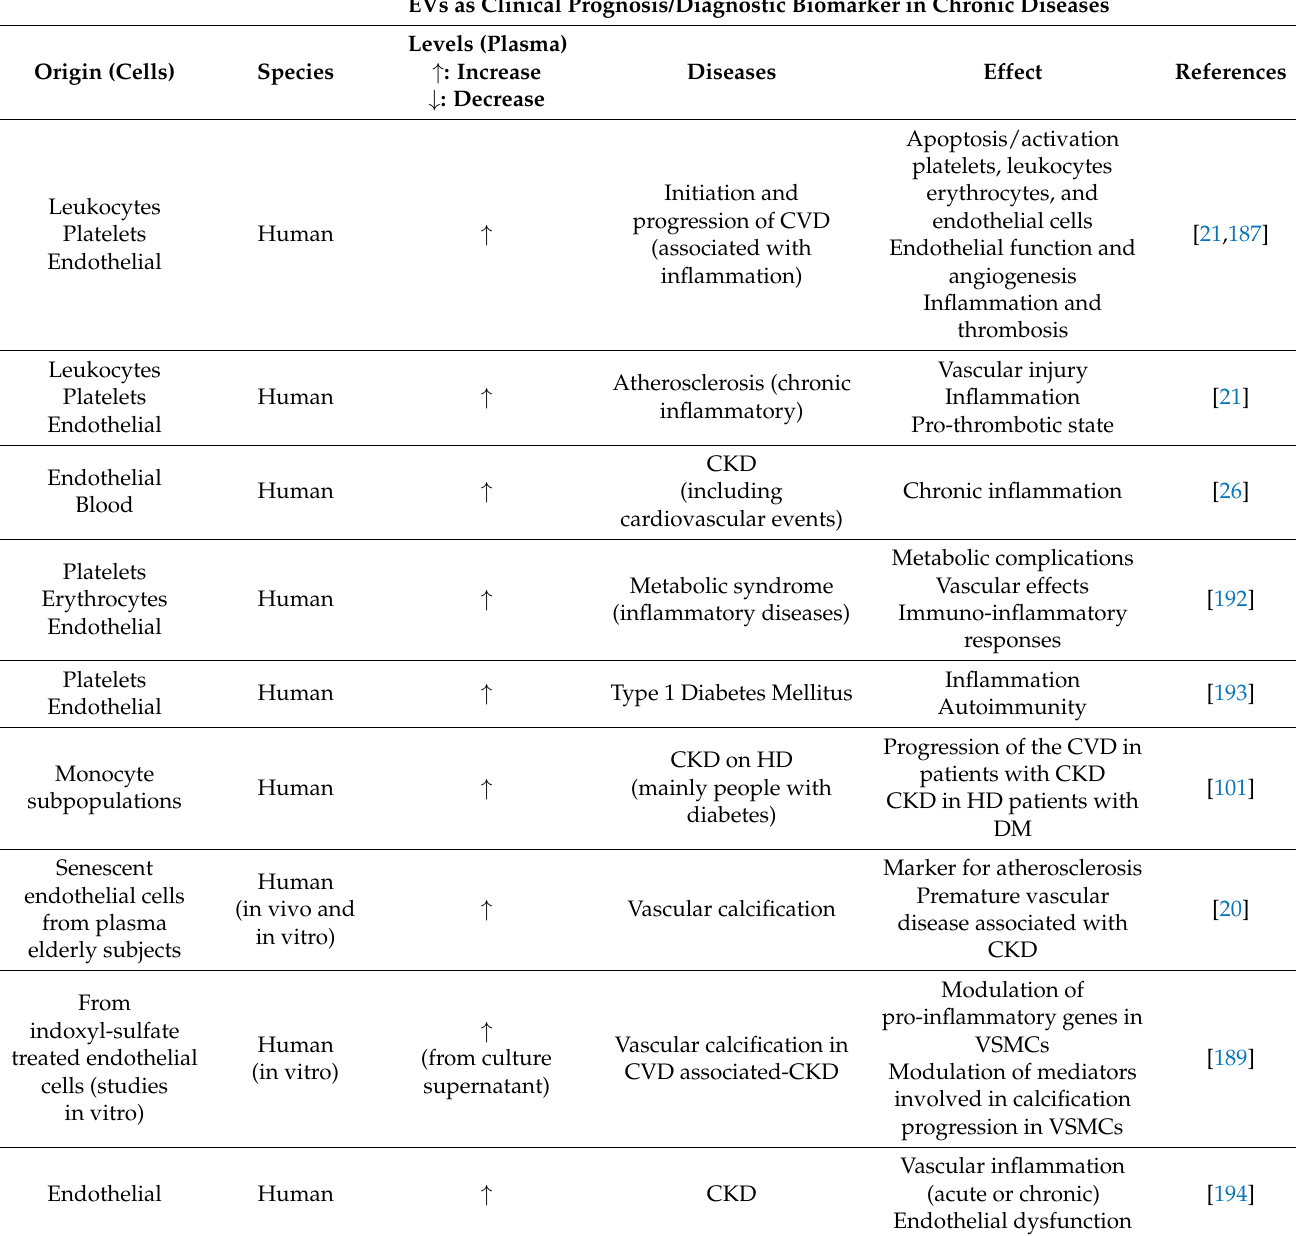
Table 2. EVs are involved in the pathogenesis of CVD-associated-CKD. EVs as Clinical Prognosis/Diagnostic Biomarker in Chronic